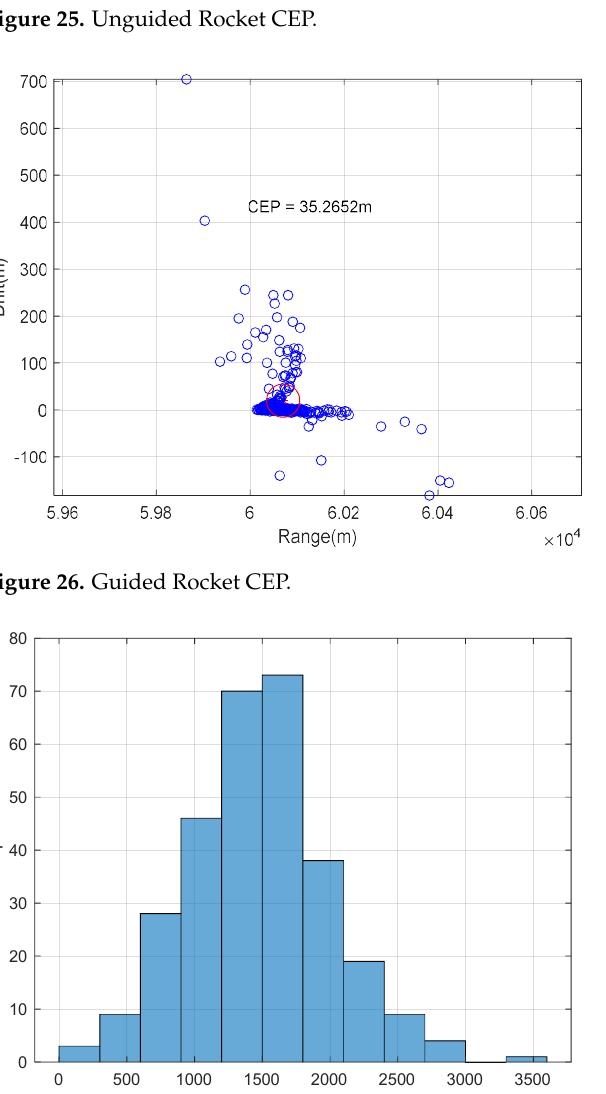
Figure 25. Unguided Rocket CEP.